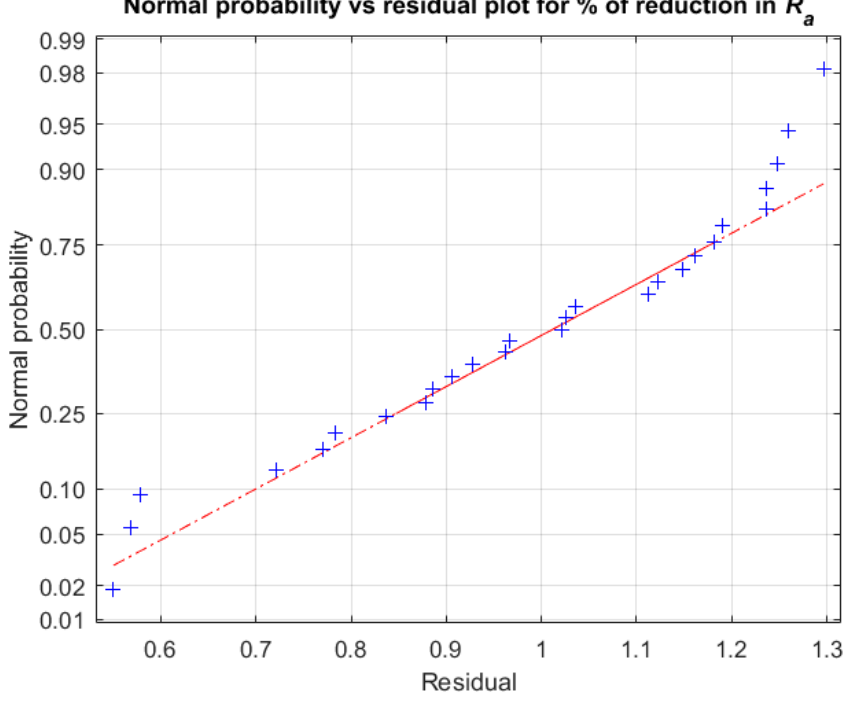
Figure 9. Normal probability vs. residual plot for SiC.